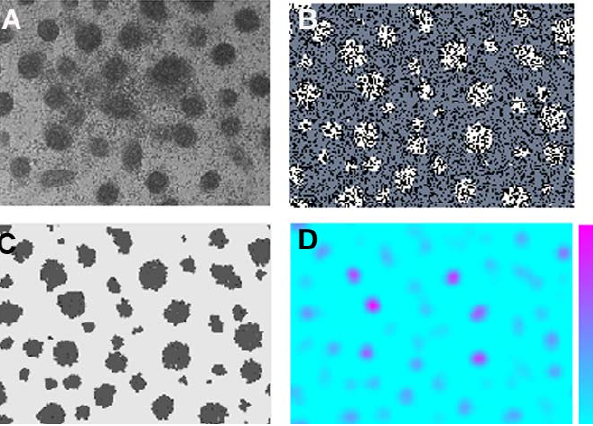
Figure 3. In Vitro and Oscillatory Regime Simulation Images for Spot-Like Precartilage Condensations (A) Discrete spot-like precartilage condensations that have formed after 72 h in a micromass culture of 5-d leg bud apical zone limb mesenchymal cells, visualized by Hoffman Contrast Modulation optics. Actual size of the microscopic field is 1 3 1.4 mm, and each condensation contains approximately 30–50 tightly packed cells. (B) Spatial grid of equal physical size to (A) containing over 6,000 cells produced by simulation using the parameter values in Table 2 showing clusters of fibronectin-producing differentiated cells (white), nondiffer- entiated cells (blue-gray), and empty space between cells (black). Each cluster contains on average ; 30 cells. (C) Spatial grid of same simulation as (B) showing fibronectin-rich patches (black) produced by the differentiated cells. (D) Spatial grid of same simulation as (B) showing activator concen- trations at time slightly after the initial onset of cell differentiation. The color bar indicates the range, with magenta for high concentration and light blue for low